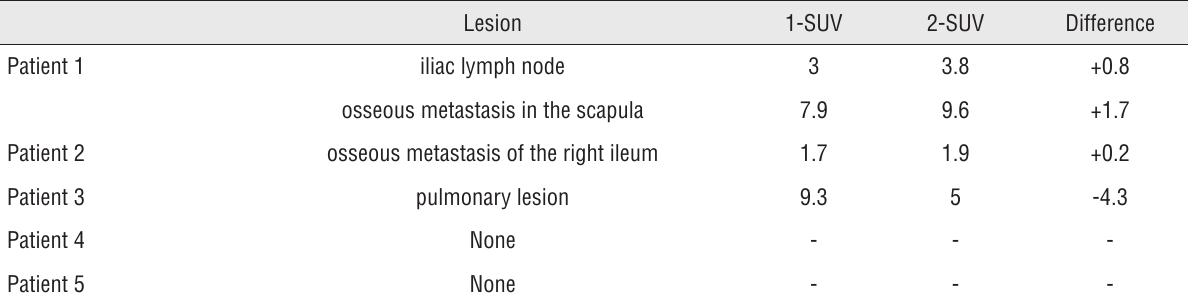
Table 5 - Findings